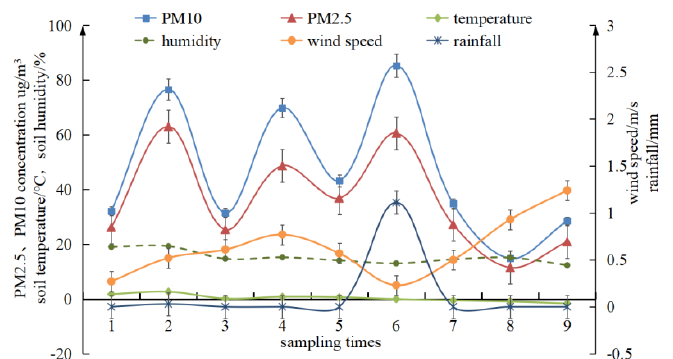
Figure 19. Yanqing straw mulching.